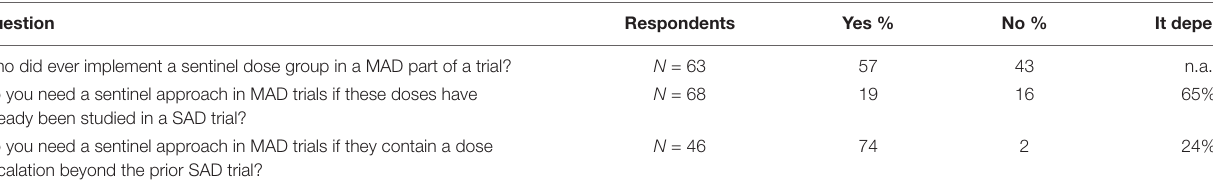
TABLE 3 | An overview on the use of sentinel subjects in a MAD